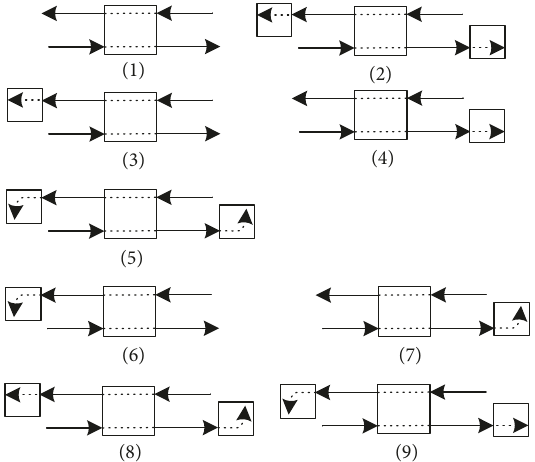
Figure 6: Nine cooperative phase switching possibilities of one light